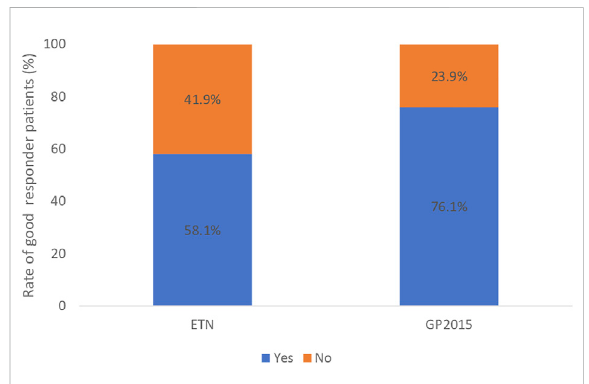
FIGURE 3 Rate of good responder patients: who achieved low disease activity (DAS28-CRP ≤ 3.2) at week 52 and show a signi fi cant change of 1.2 in DAS28-CRP from baseline to 52 weeks. It was reached in 43 (58.1%) and 16 (76.1%) patients in the ETN and GP2015 group respectively, p -value =